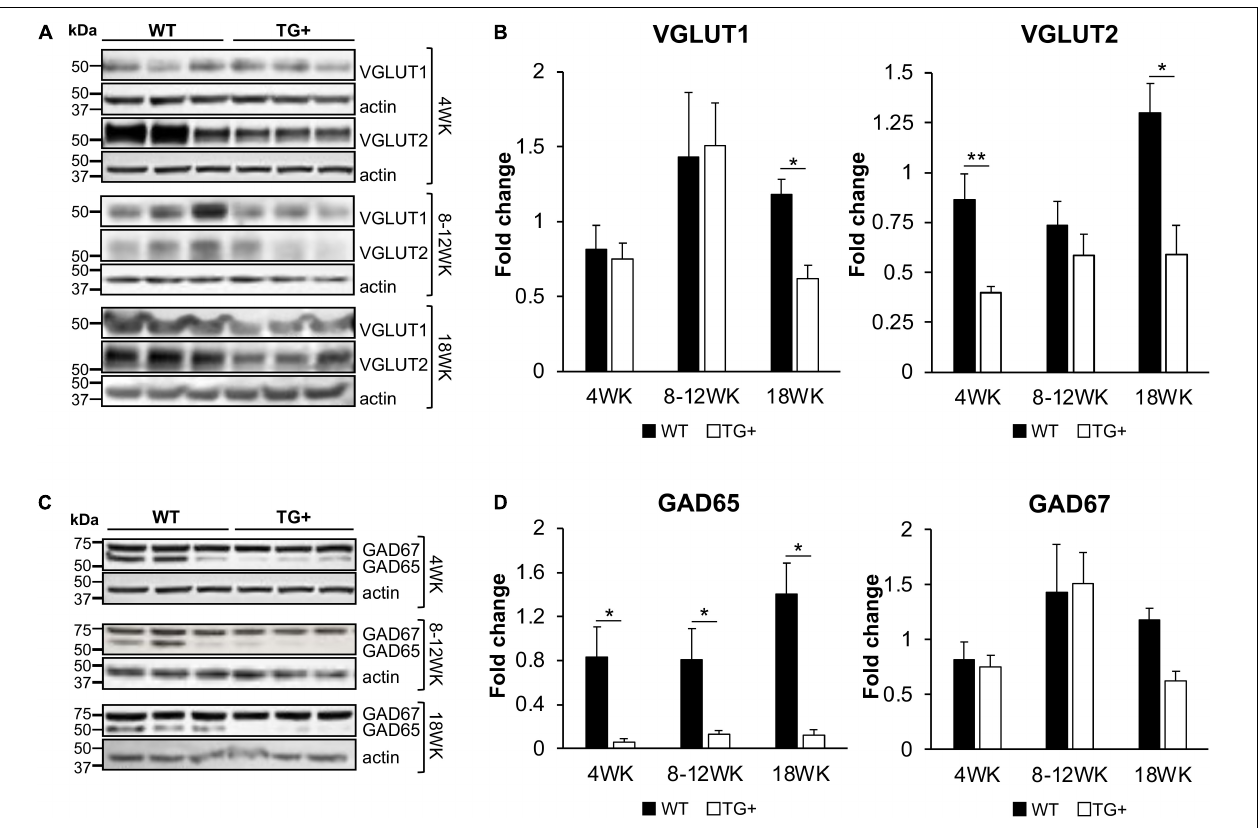
FIGURE 5 | FRDAkd mice show progressive glutamatergic and GABAergic synaptic deficits in the cerebellum. Western blot and quantification of VGLUT1, VGLUT2 (A,B) , GAD65, and GAD67 (C,D) levels normalized to internal control actin in WT and TG + mice at 4 weeks, 8–12 weeks, and 18 weeks of dox treatment (Stats: WT, n = 3, TG +, n = 3, mean ± SEM, two-tailed, unpaired Student’s t -test, * P < 0.05, ** P <